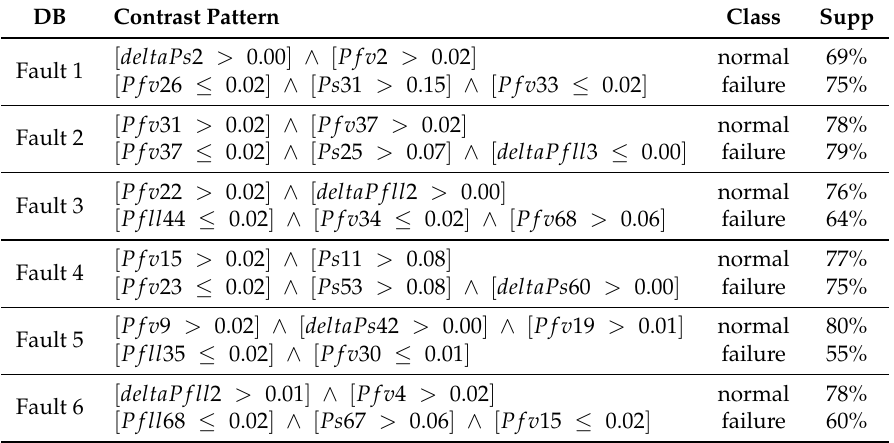
Table 7. Examples of contrast patterns extracted from our proposed database, as two-class problems, by using